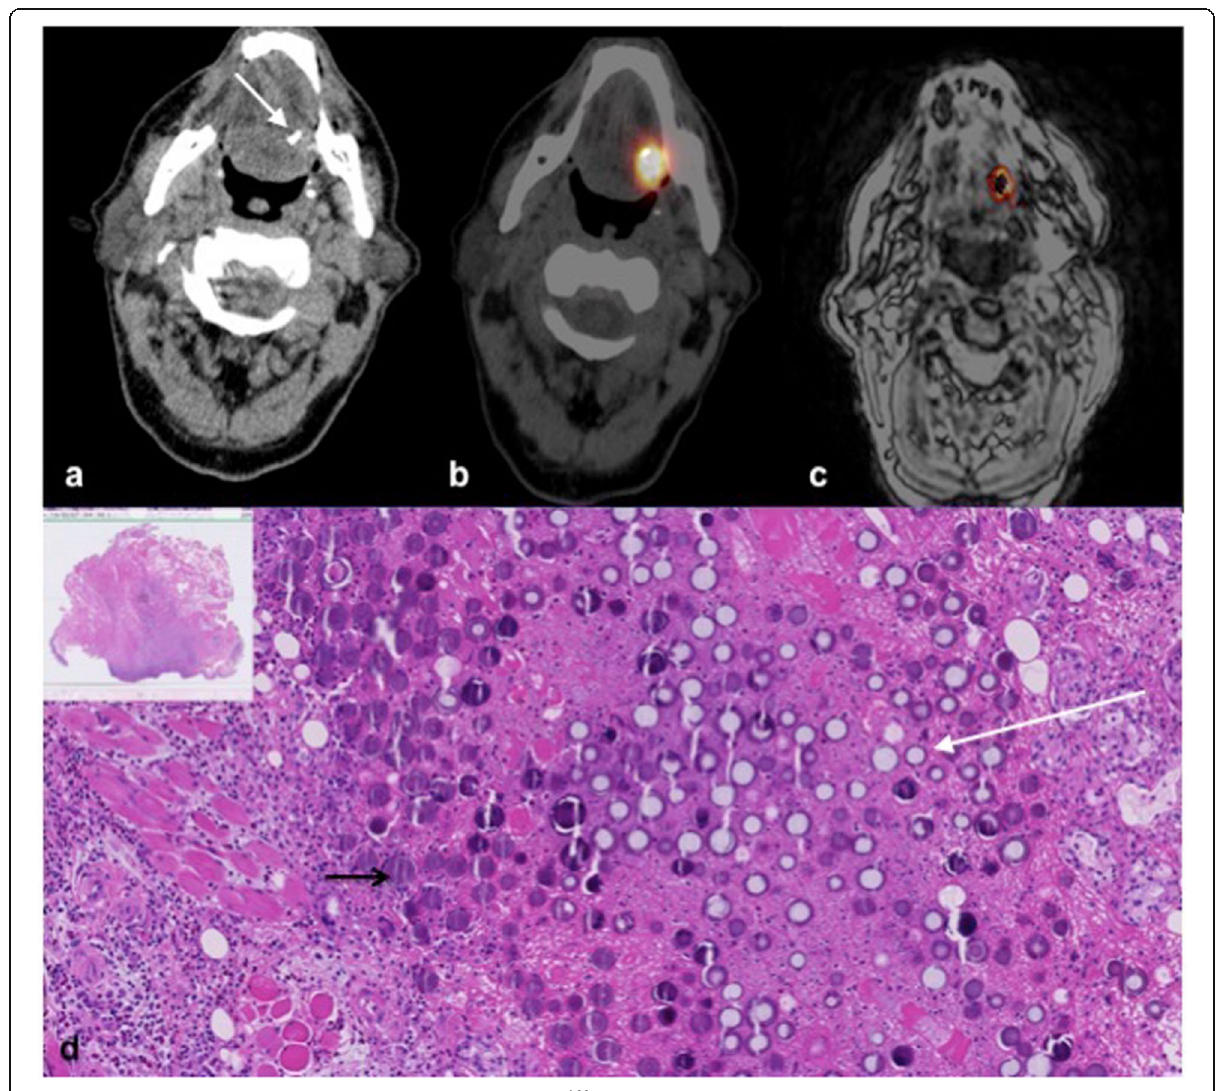
Fig. 4 Multimodality imaging and histopathology after injection of 166 Ho microspheres in patient number 3. a Unenhanced computed tomography (CT); microspheres are visible as hyperdense area on the left side of the tongue (arrow). b Single-photon computed tomography/CT; the location of the microspheres dose distribution is observed as a large hotspot. c Magnetic resonance imaging; with dose reconstruction derived and overlaid on this image, obtained with a T2* multi-gradient echo weighted sequence acquiring 16 echoes (TR/TE1/ Δ TE: 1000 ms/1.33 ms/1.15ms; flip angle 70°), the black centre has 166 Ho microsphere concentration > 10 mg/ml, resulting in a rapid signal loss restricting the nonlinear least squares (exponential) fit to compute a T2* value and thus a dose value. d Histopathology. The haematoxylin and eosin staining shows a moderately differentiated and partly invasive growing oral squamous cell carcinoma with clusters of 166 Ho microspheres. The black arrow indicates purple spherical structures that are sliced microspheres. The white arrow indicates white spherical structures that are partly or totally removed microspheres by slicing the tissue in 4- μ m slices. In the direct environment of the microspheres, a necrotic tissue is seen, while the periphery is unaffected by radiation. Infiltration of lymphocytes is most likely radiation unrelated and often seen in oral squamous